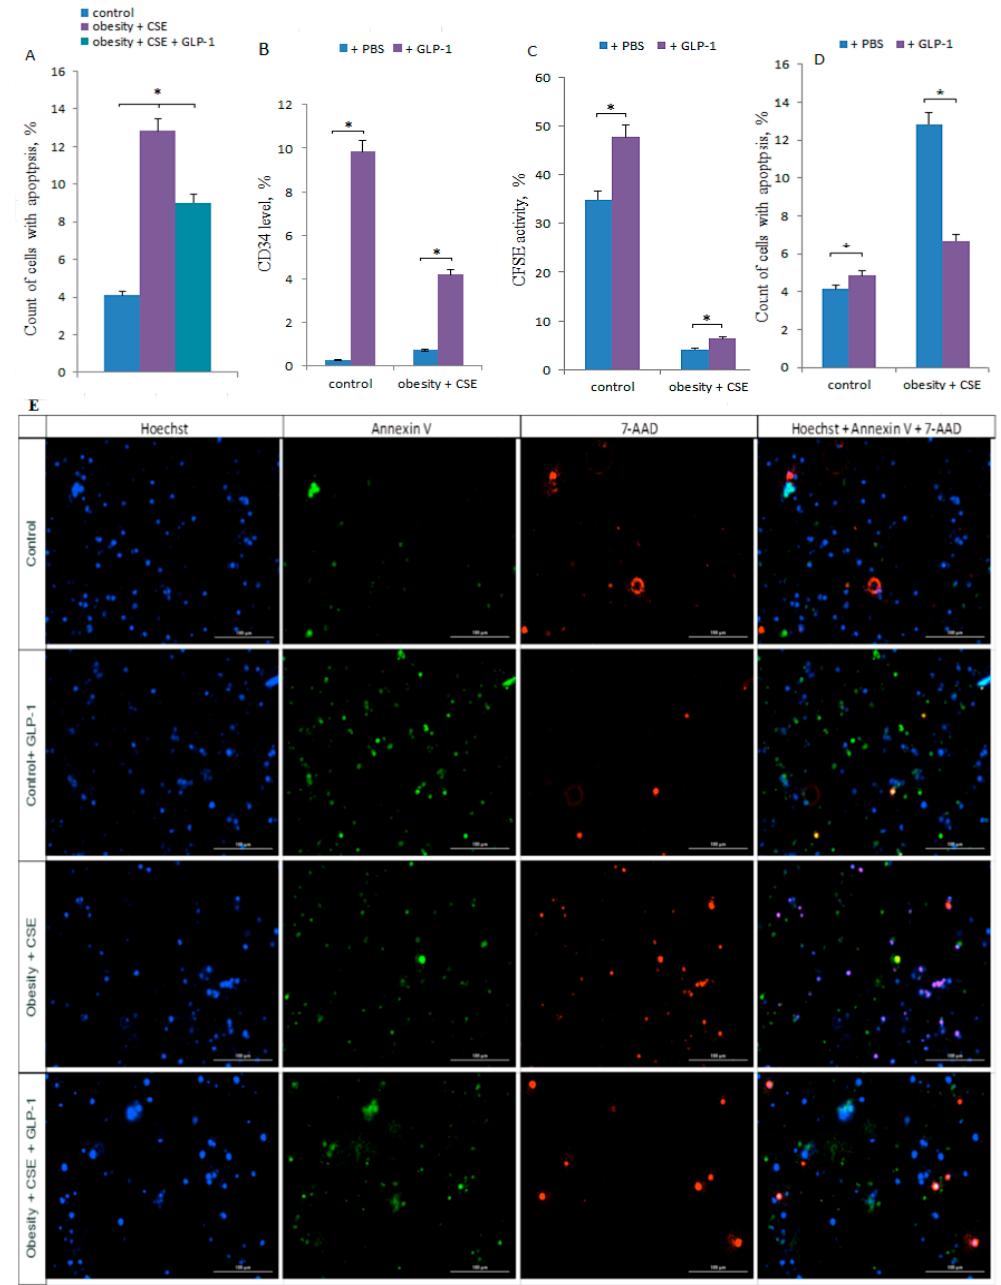
Figure 7. GLP-1 treatment effects on CD31 + endothelial cells isolated from the lungs of female C57BL/6 mice. ( A ) The count of CD31 + cells with apoptosis in the lungs of female C57BL/6 mice on the 188th day of the experiment. * - significance of difference compared with control ( p < 0.05); ■ - significance of difference compared with the obesity + CSE group ( p < 0.05). ( B – D ) CD31 + endothelial cells from lung were precultured for 5 days, incubated with or without GLP-1 (10-7 M) for 24 h and then labeled with Hoechst, CD34 FITC ( B ), CFSE ( C ), Annexin V and 7-AAD ( D ) prior to fluorescence microscopic analysis. ( B ) The level of CD34 + cells after culture, ( C ) CFSE activity after culture, ( D ) the count of cells with apoptosis after culture. All data are expressed as mean ± SD, *—significance of difference compared with control without GLP-1 ( p < 0.05). ( E ) 20 × images of CD31 + cells stained with: Hoechst (blue) to identify cell nuclei; Annexin V (green); 7-AAD (red); (Hoechst + Annexin V + 7-AAD) composite image using all three colors. Determination of the percent of cells in apoptosis is made by the ratio of cells counted in green and red channel to total cells counted using blue (DAPI) channel. All scale bars are 100 µ